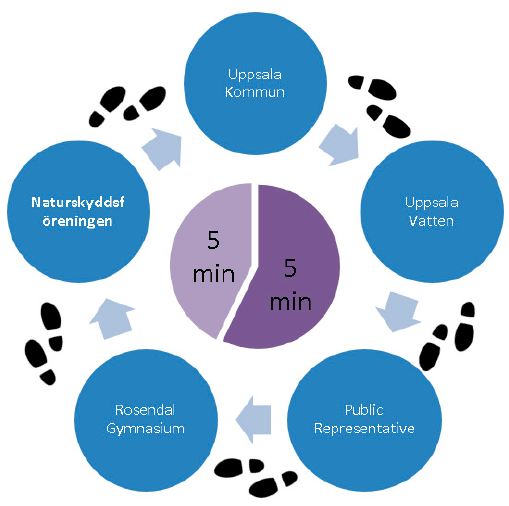
Figure 1. Speed-dating carousel. Uppsala Kommun : local authority; Uppsala Vatten : drinking water company; Rosendal Gymansium : school; and Naturskyddsföreningen : nature conservation NGO.